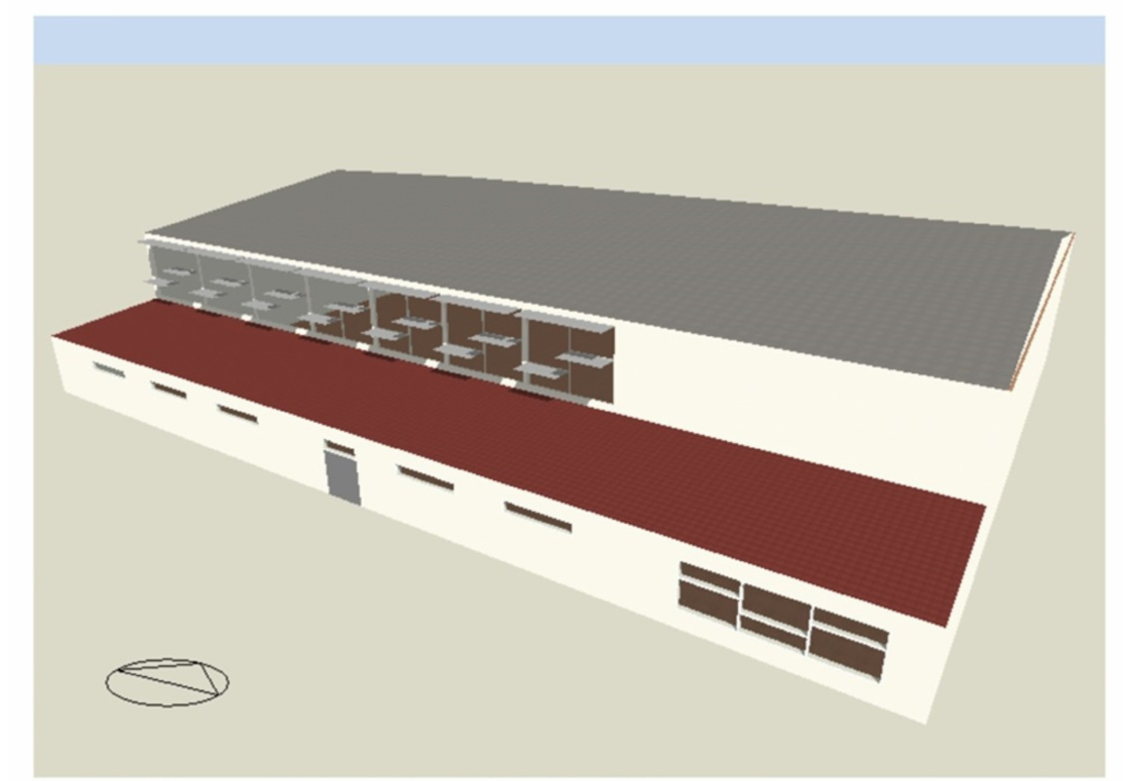
Figure 4. South façade of passive sports hall building in Słomniki generated in the DesignBuilder